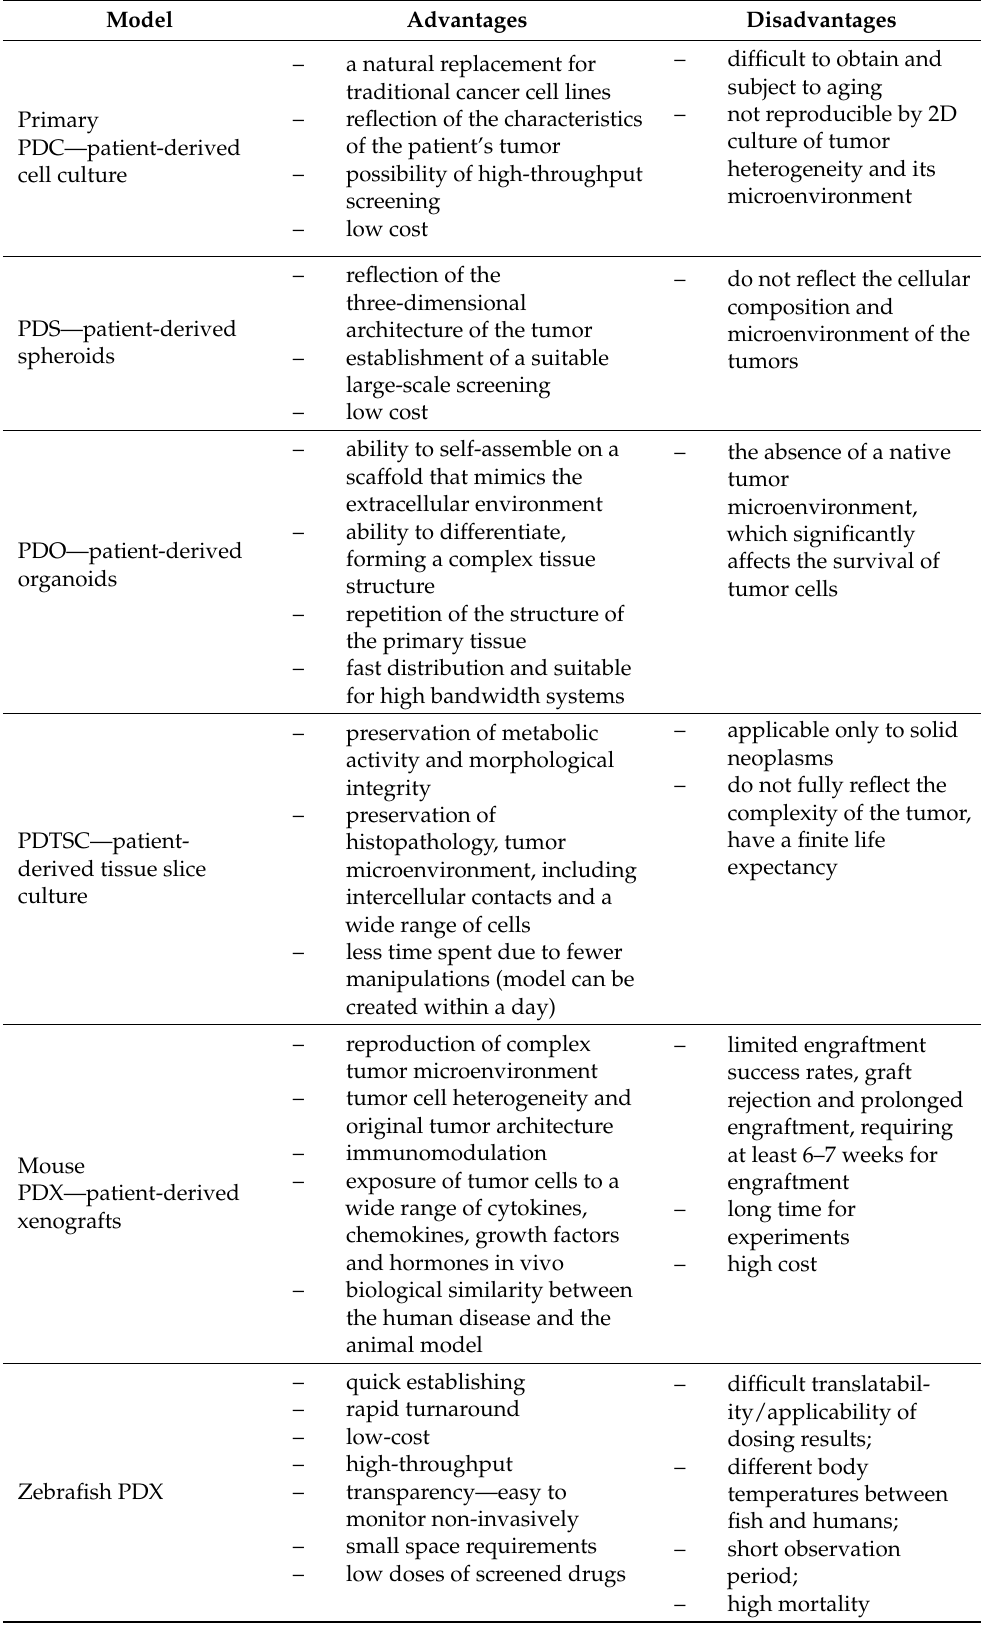
Table 2. Advantages and disadvantages of patient-derived